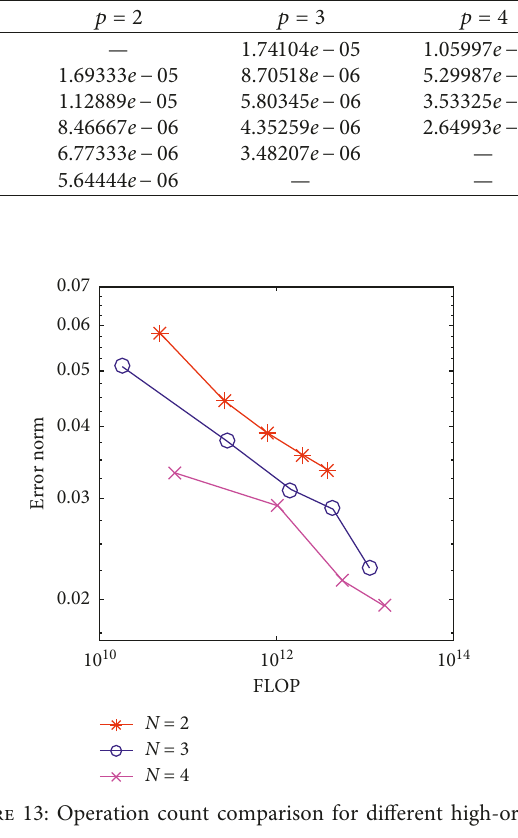
Table 5: Time increment (s) of different refinement levels of CASE.